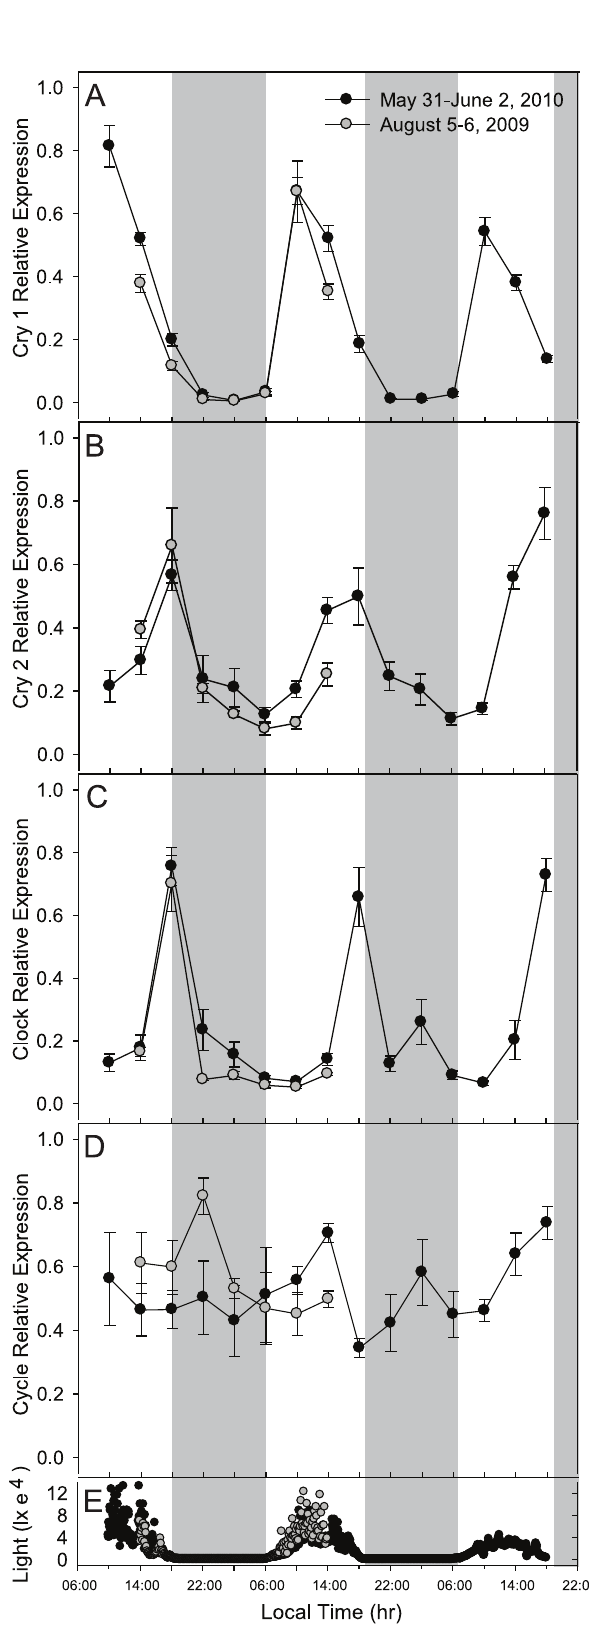
Figure 3. Relative expression of F.fragum clock genes over the diel light cycle: F. fragum samples were collected between August 5 and 6, 2009 (gray circles) and May 31 and June 2, 2010 (black circles). Horizontal gray bars indicate nighttime. Relative expression of cry1